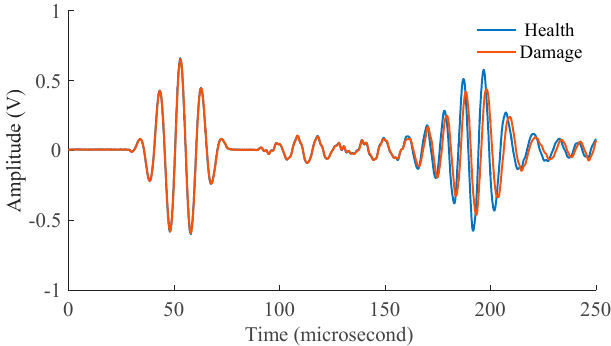
Figure 11. The Lamb wave signals without damage and with damage.